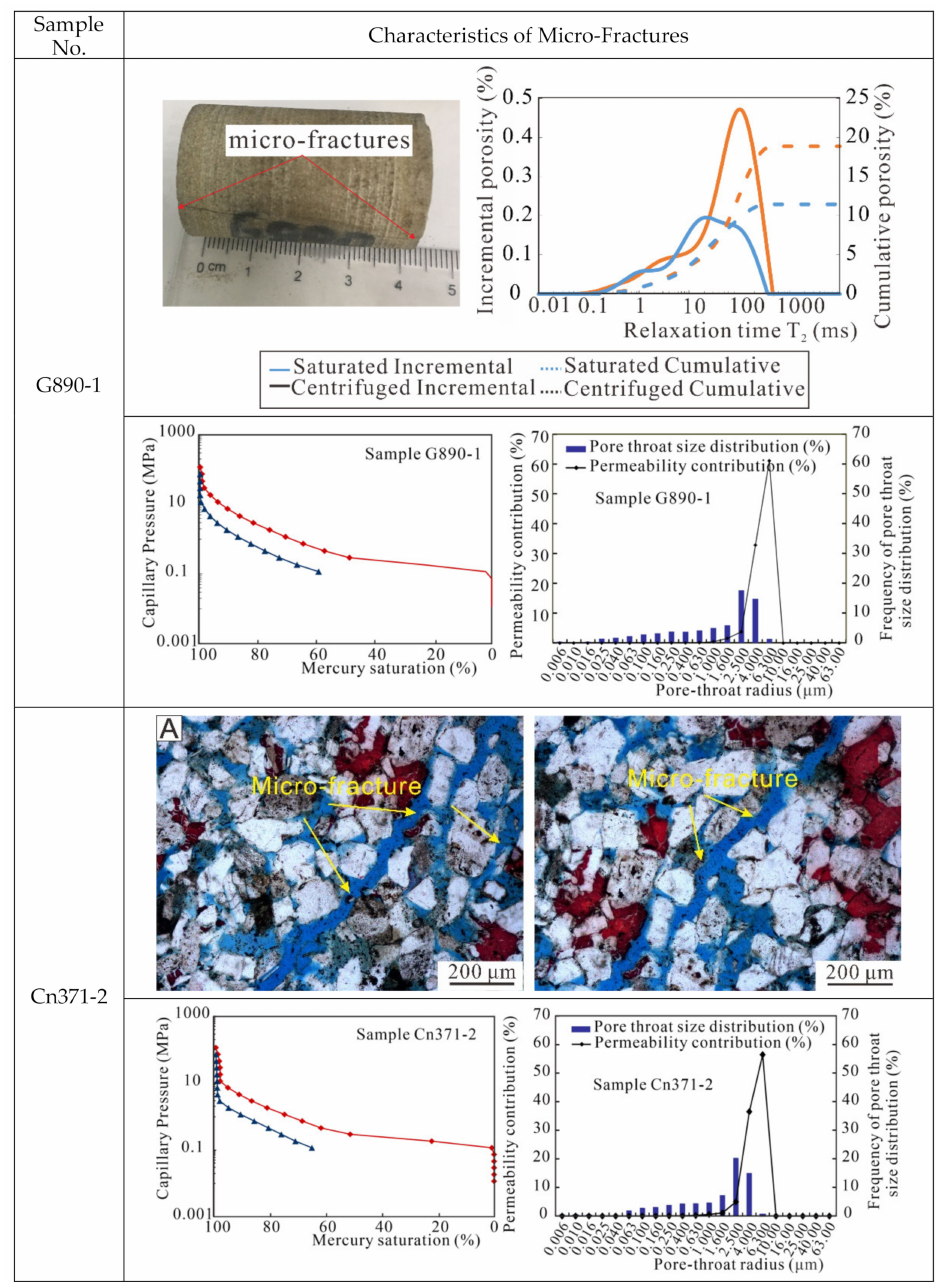
Figure 7. Characteristics of micro-fractures of cores, photomicrographs, MICP, and NMR plots (samples Cn371-2 and